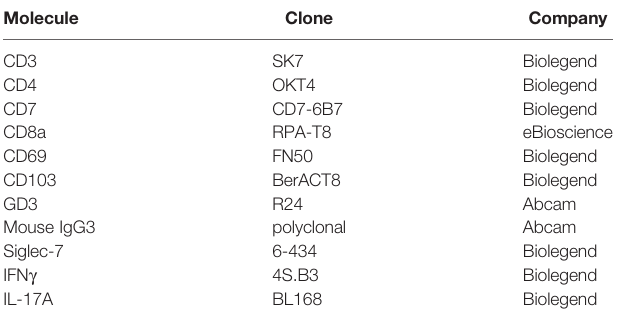
TABLE 2 | Antibodies for the fl ow cytometry.